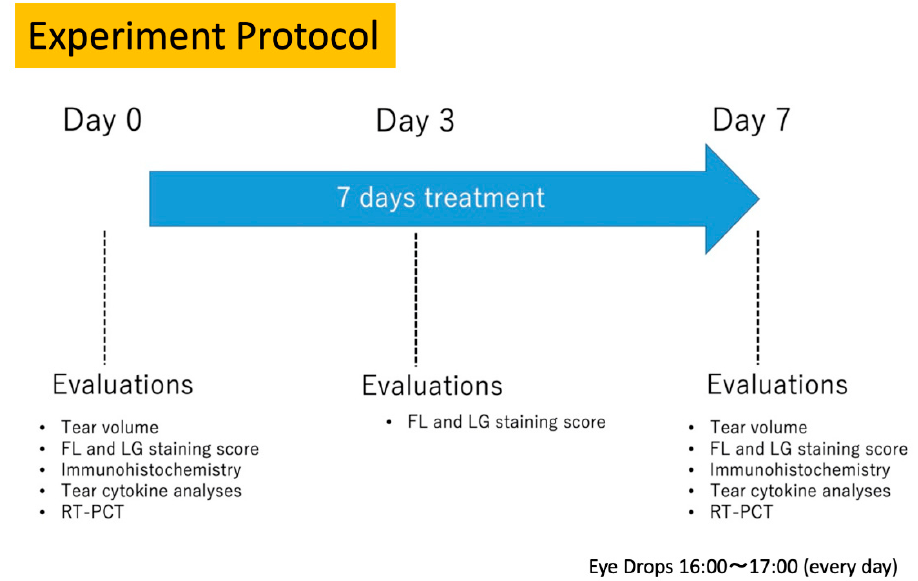
Figure 1. Diagram showing the experimental protocol for the Phase 2 ocular surface safety